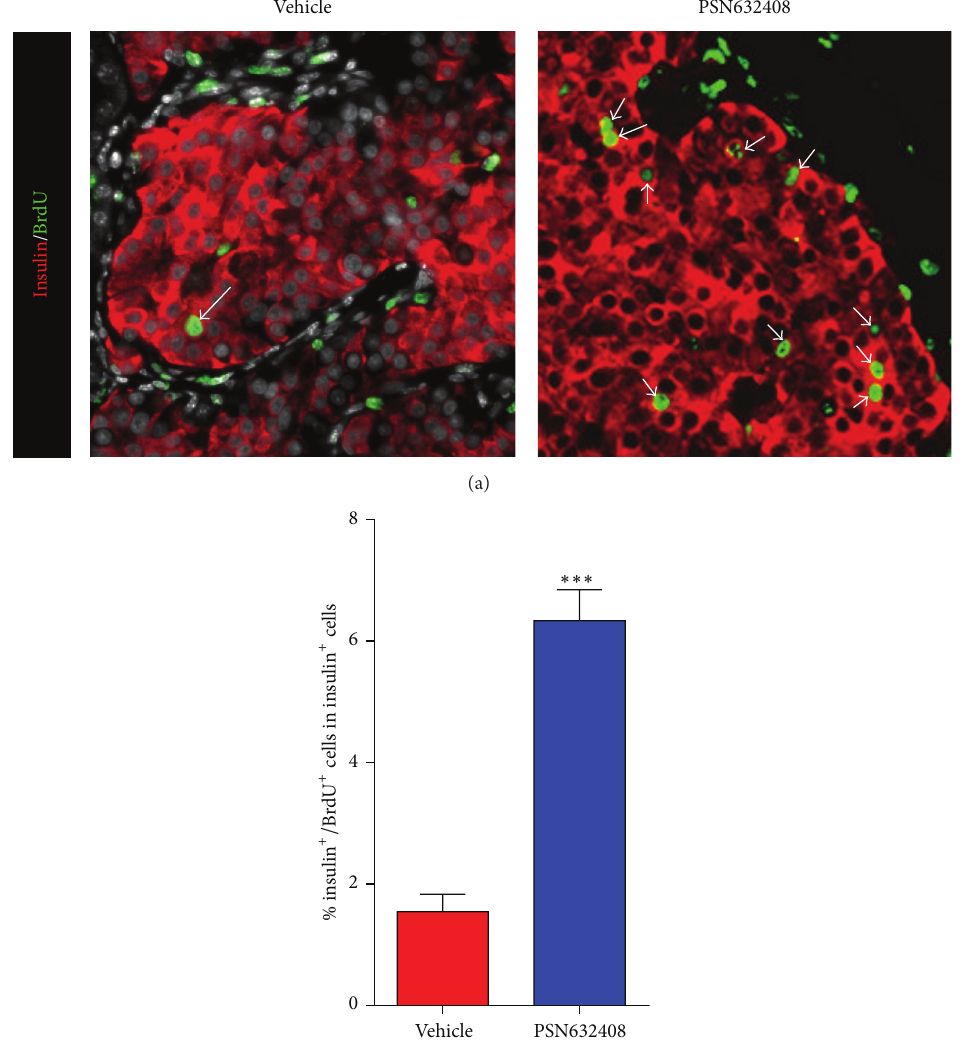
Figure 4: (a) Immunofluorescent staining for insulin (red color) and BrdU (green color) in human islet grafts from PSN632408- and vehicle- treated mice with normoglycemia at 4 weeks after transplantation. White arrows show insulin/BrdU copositive cells in human islet grafts. (b) Percentage of insulin/BrdU copositive cells among total insulin positive cells in human islet grafts. The average percent of insulin/BrdU copositive cells among total insulin positive cells was significantly higher in PSN632408-treated mice ( 𝑛 = 9 ) compared with vehicle-treated mice ( 𝑛 = 4 ) ( ∗∗∗ 𝑃 < 0.001